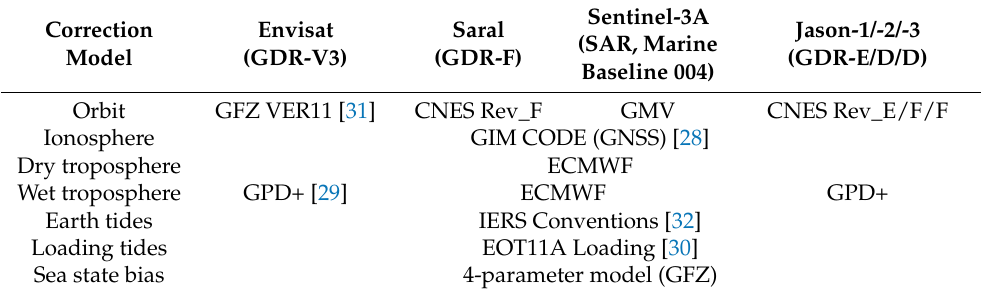
Table 2. Correction models applied for the instantaneous sea surface heights from different